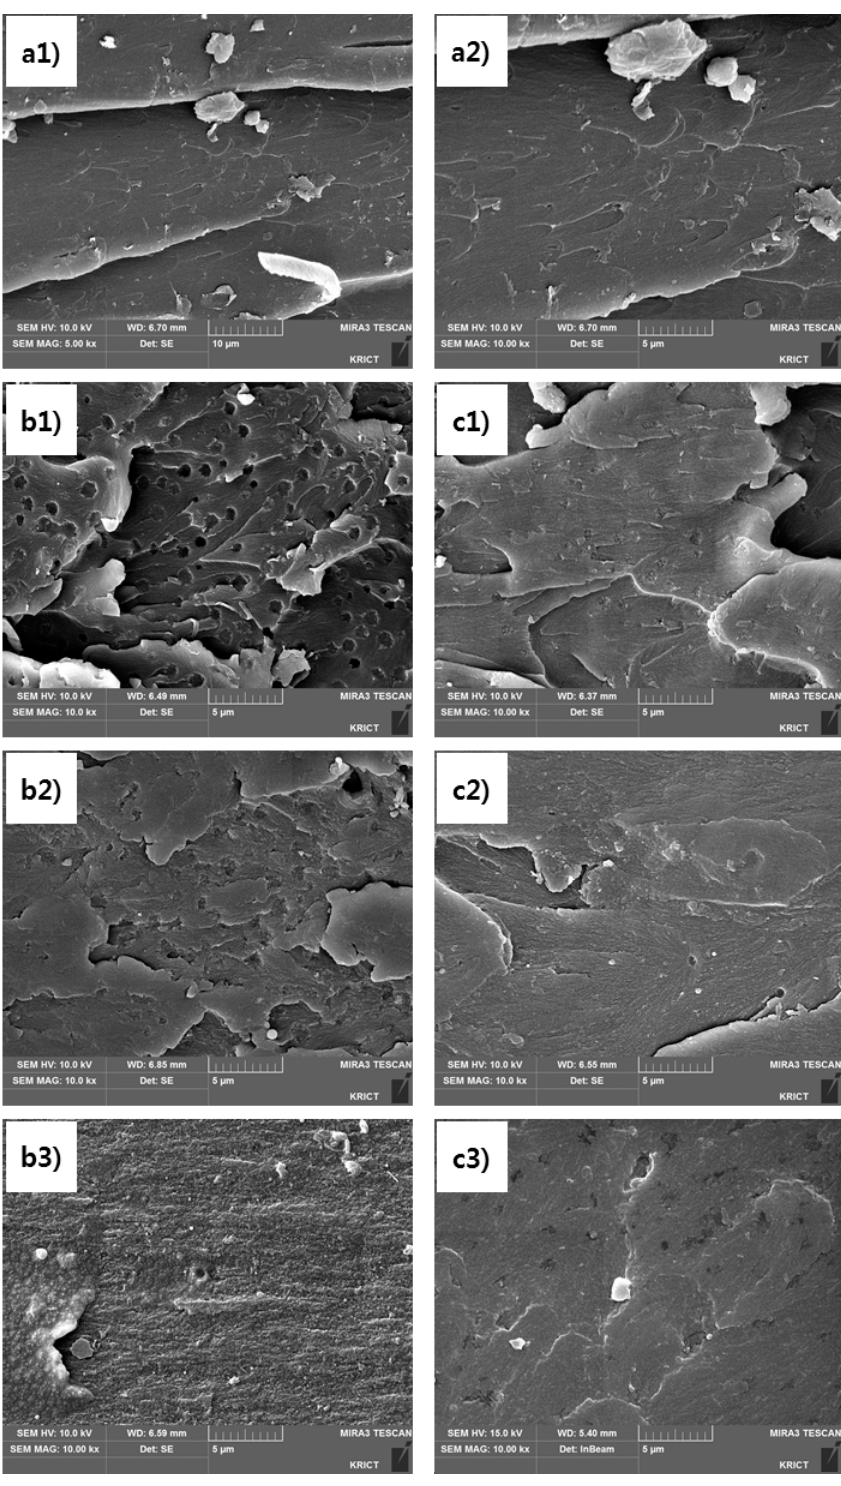
Figure 11. Scanning electron microscopy (SEM) images of epoxy compositions containing Ref PU or EPPU: ( a1 ) neat epoxy at 5000× magnification, ( a2 ) neat epoxy at 10,000 × magnification; ( b1 – b3 ) epoxy compositions with 10, 20, and 30 phr Ref PU; ( c1 – c3 ) epoxy compositions with 10, 20, and 30 phr EPPU.